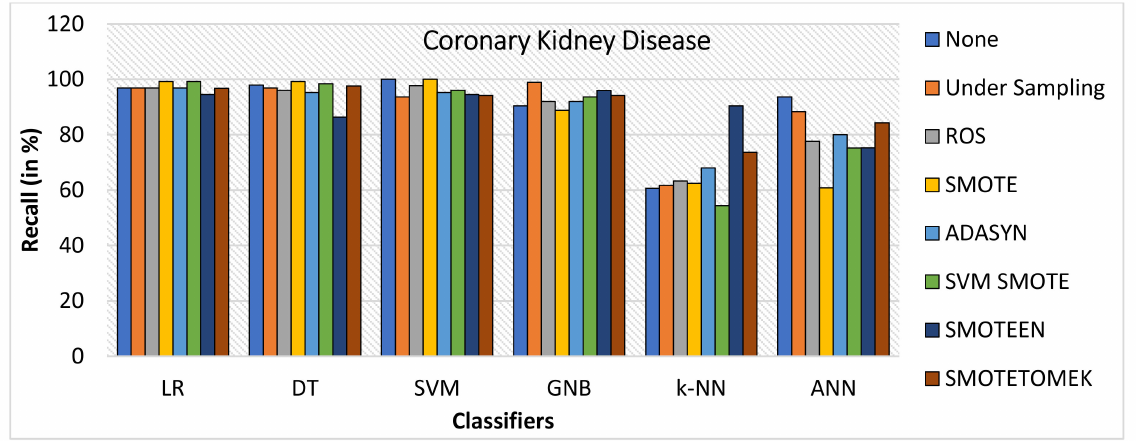
Figure 16. Recall for kidney disease dataset of balancing algorithms over six